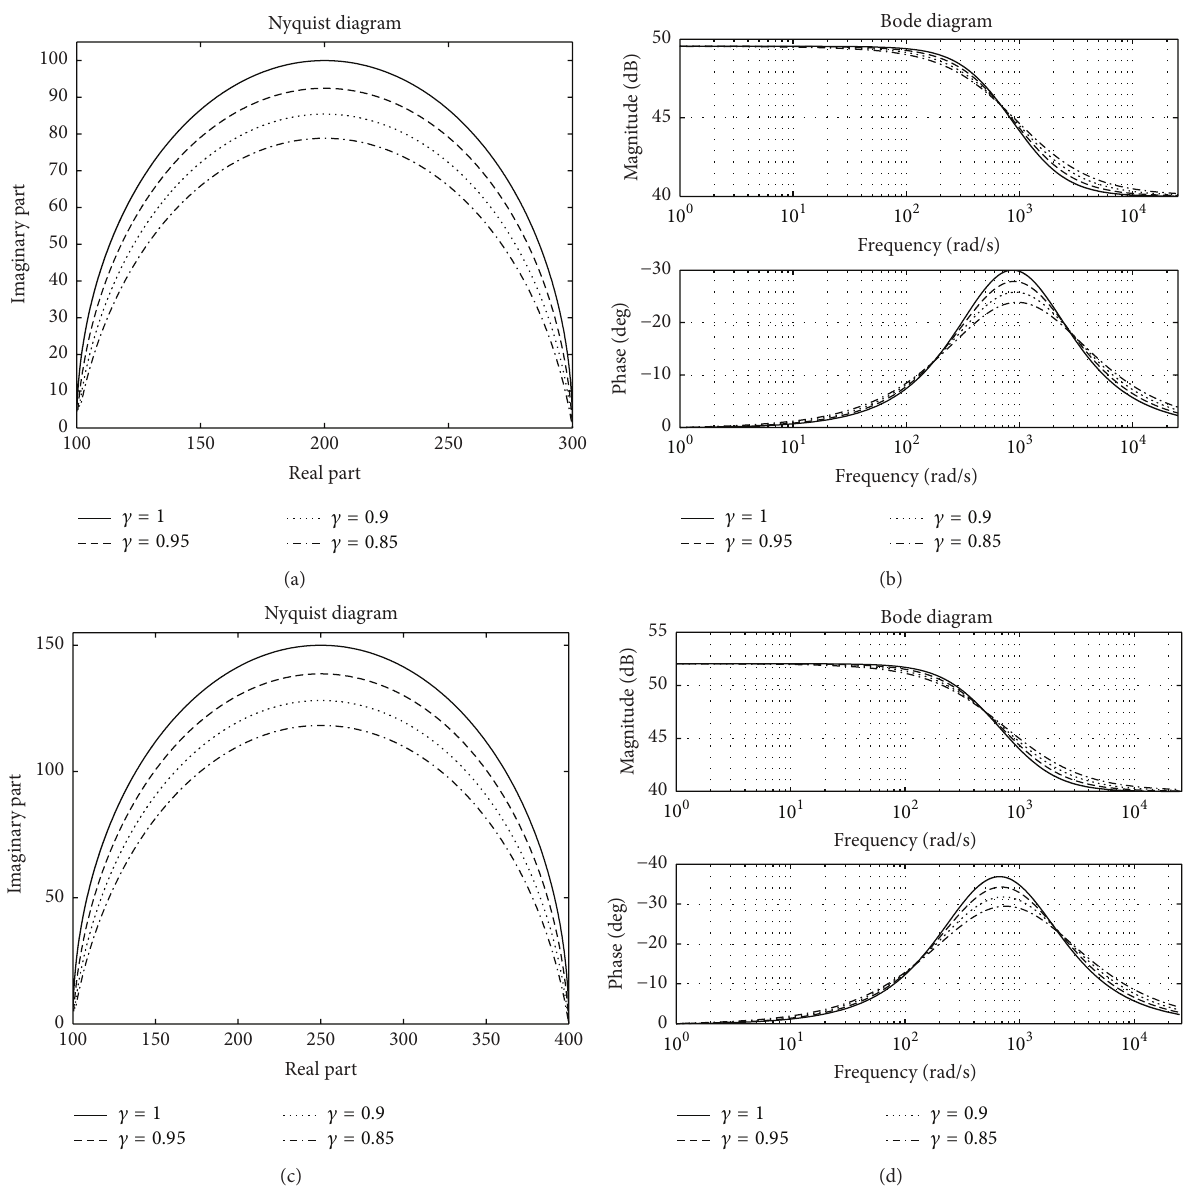
Figure 2: Nyquist and Bode diagram for the model of polarizable electrode, Caputo derivative approach, in (a) and (b): 𝑅 𝑠 = 100 Ω , 𝐶 = 1 −4 F, and 𝑅 𝑝 = 200 Ω for 𝛾 = 1 , 𝛾 = 0.95 , 𝛾 = 0.9 , and 𝛾 = 0.85 ; for (c) and (d), 𝑅 𝑠 = 100 Ω , 𝐶 = 1 −4 F, and 𝑅 𝑝 = 300 Ω for 𝛾 = 1 , 𝛾 = 0.95 , 𝛾 = 0.9 , and 𝛾 = 0.85